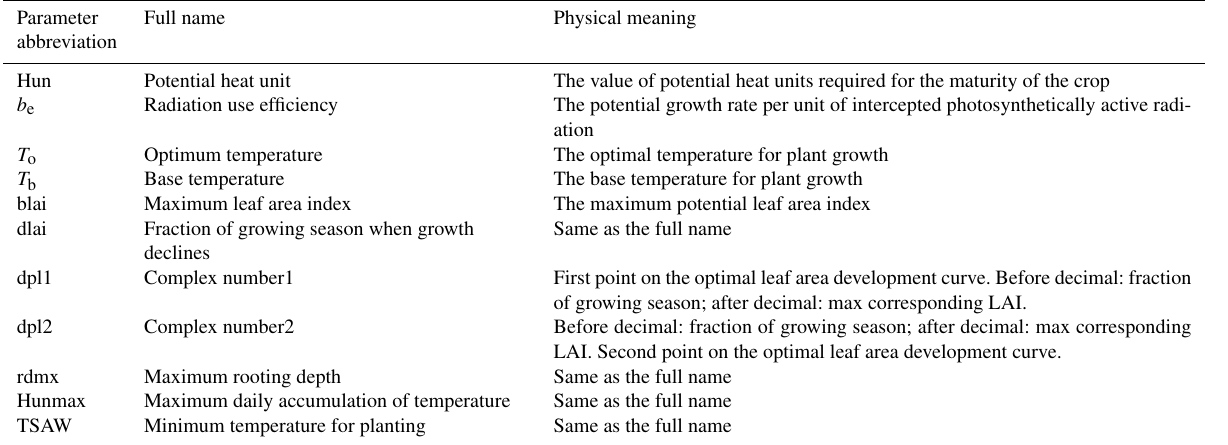
Table 1. Parameter abbreviations and